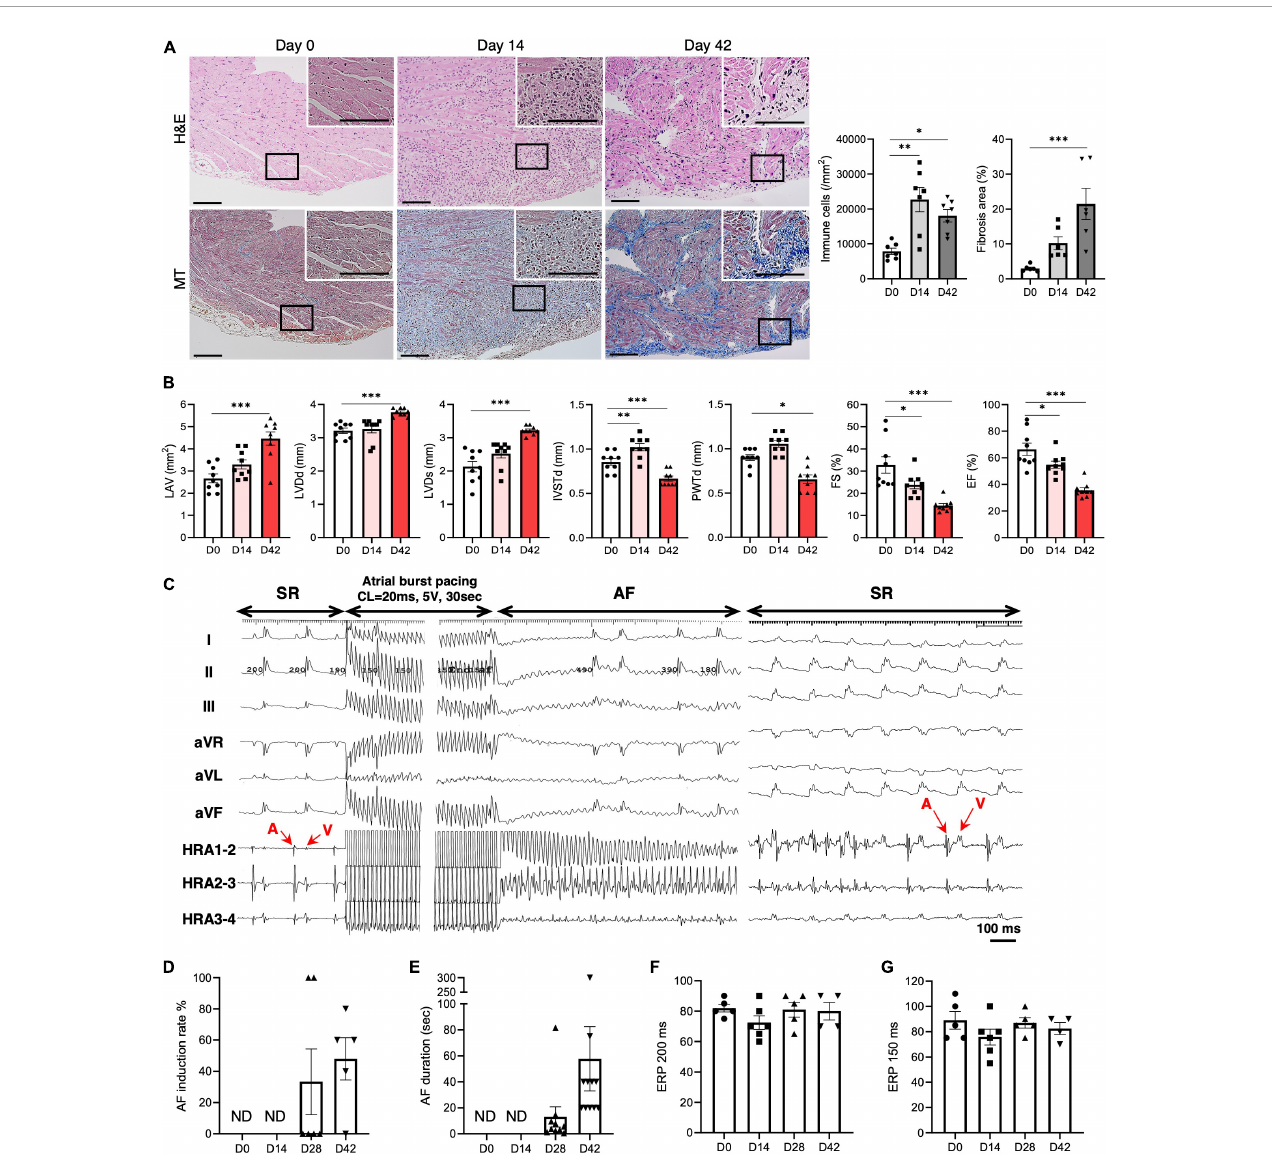
FIGURE1 AF vulnerability in inflammatory atrial cardiomyopathy. (A) Representative histology of the atrium on days 0, 14, and 42 after immunization with MyHC- α (scale bars = 50 µ m). The right bar graphs indicate the number of infiltrating mononuclear cells and fibrotic areas in the atria. (B) The bar graphs represent echocardiographic parameters at the indicated time-points. (C) The AF induction study was performed at baseline and 14, 28, and 42 days after MyHC- α immunization. Representative surface and endocardial electrocardiograms are shown. AF was induced by atrial burst pacing followed by spontaneous termination to sinus rhythm (SR). AF induction rate (D) , AF duration (E) , and right atrial ERP at basic cycle lengths of 200 ms (F) and 150 ms (G) . The results are presented as mean ± SEM. ∗ P < 0.05, ∗∗ P < 0.01, ∗∗∗ P < 0.001 using the Kruskal–Wallis test with Dunn’s test. MyHC- α , α -myosin heavy chain; AF, atrial fibrillation; ERP, effective refractory period; SEM, standard error of the